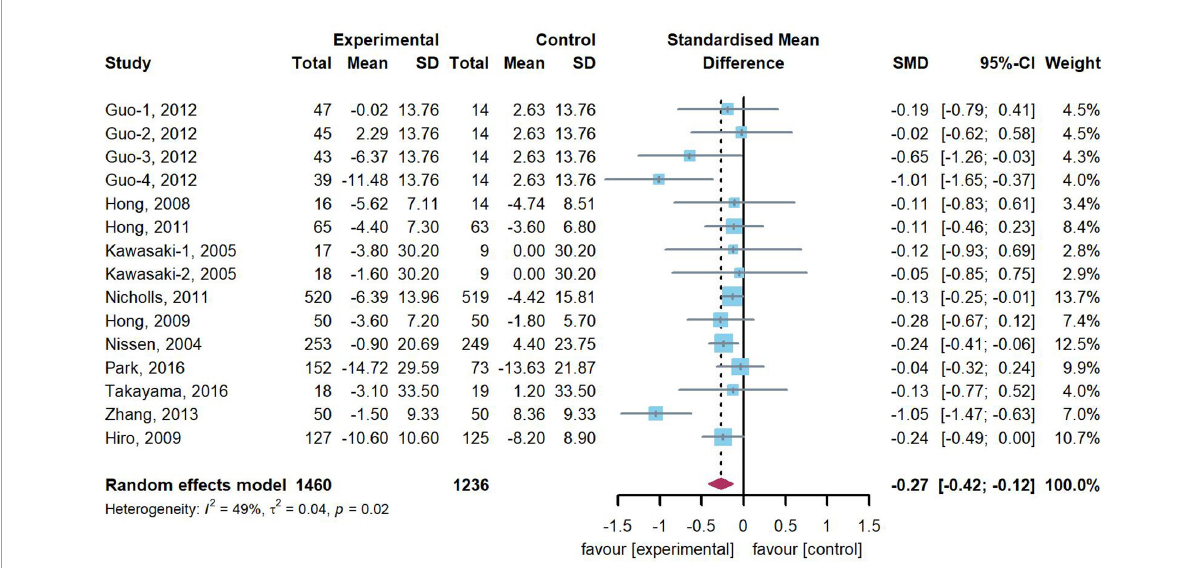
FIGURE2 Forest plot of change of TAV/PV. A meta-analysis of 15 statin-treated arms reported a significant reduction in change of TAV/PV [standardized mean difference (SMD): –0.27, 95% confidence intervals (CI): –0.42, –0.12], compared with the control arms.